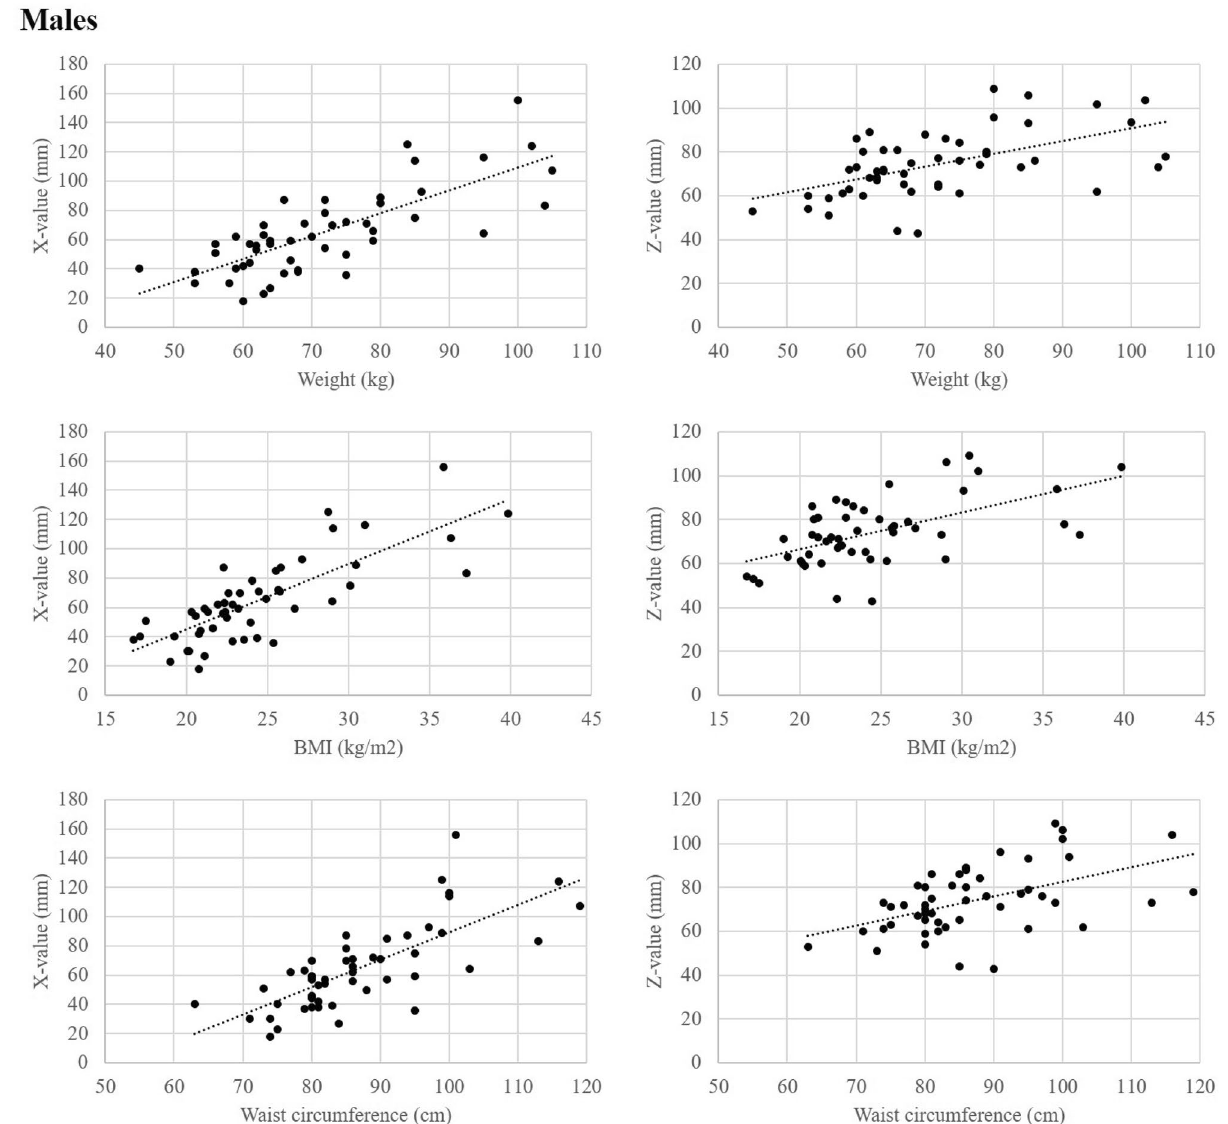
Figure 5. Relationships between weight, BMI, or waist circumference and X-value or